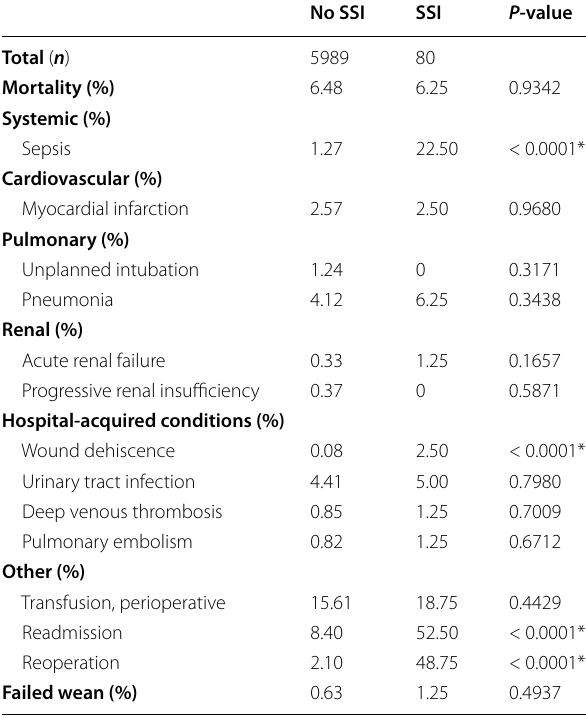
Table 4 30-day postoperative adverse events in patients undergoing hip hemiarthroplasty stratified by occurrence of surgical site